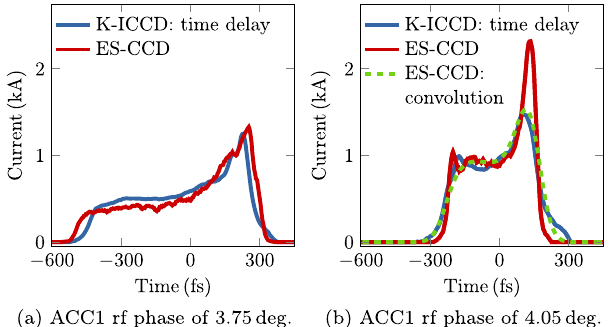
FIG. 11. Single-shot longitudinal electron bunch profiles mea- sured in the nondispersive beam line at K-ICCD by using the LuAG screen recorded with a certain time delay (blue line) and in the magnetic energy spectrometer at ES-CCD by using the YAG screen (red line) for ACC1 rf phases of (a) 3.75 deg and (b) 4.05 deg, respectively. A convolution has been applied in (b) for the measurement at ES-CCD (green dashed line) to compare the longitudinal profiles with similar